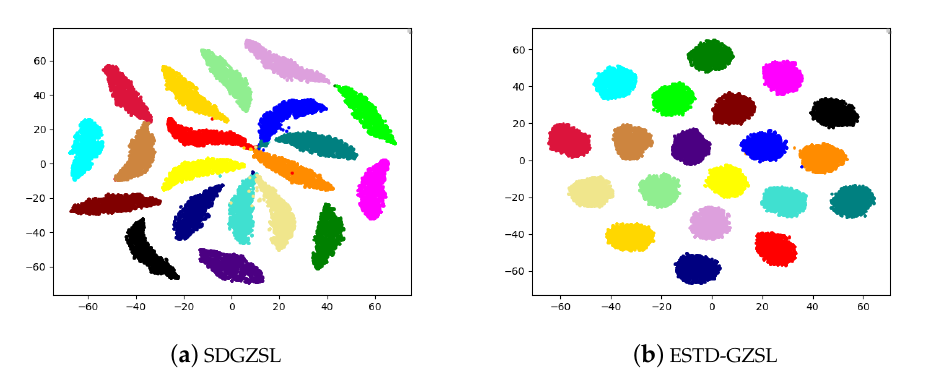
Figure 6. t-SNE visualization of the synthesized unseen visual representations of 20 unseen classes on CUB: ( a ) baseline: SDGZSL; ( b ) ours: ESTD-GZSL